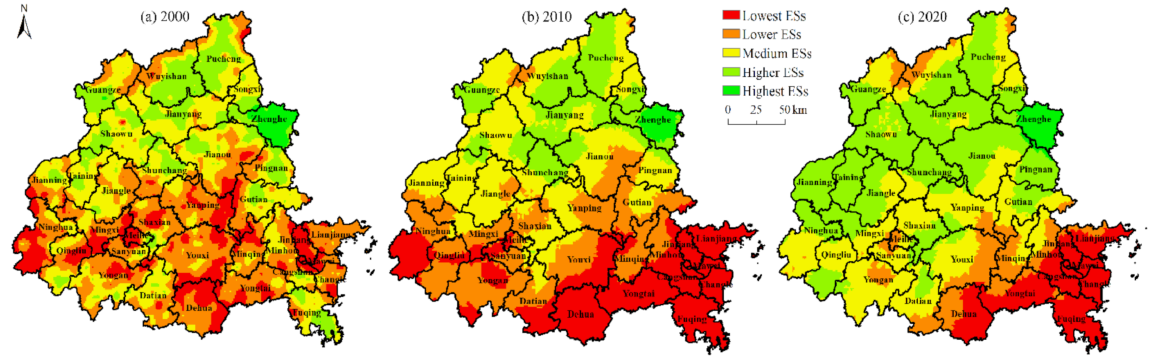
Figure 5. ( a – c ) Spatial distribution of ecosystem services from 2000 to